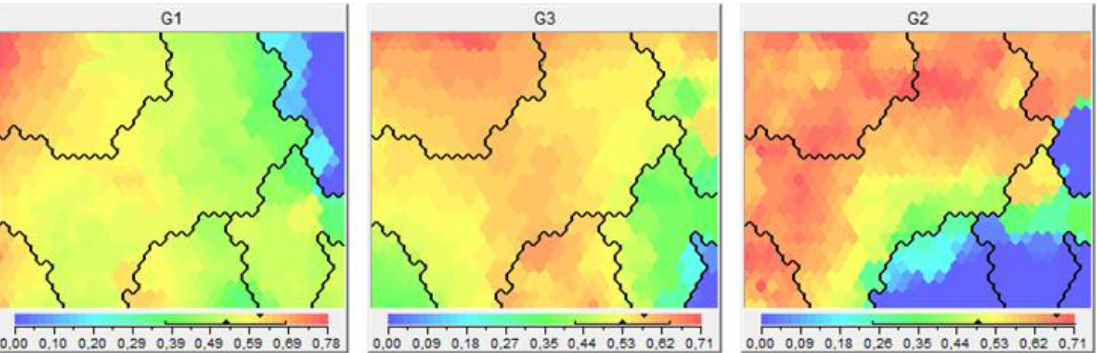
Figure 2. Cluster analysis reference